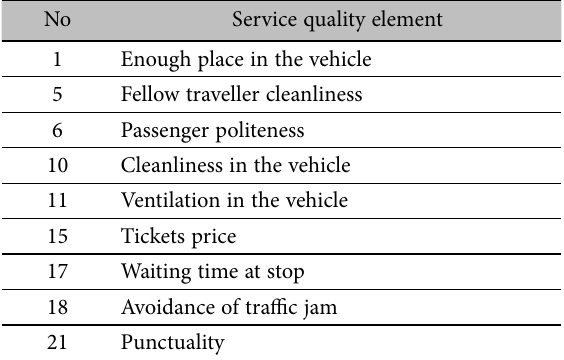
Table 2. Service quality elements that need to be improved